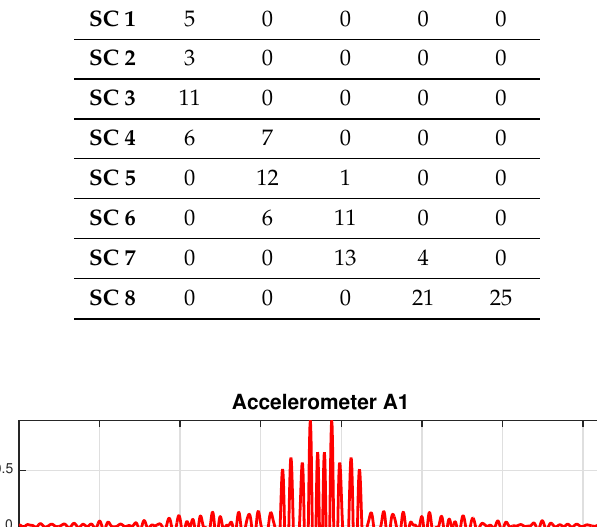
Table 2. Quantitative performance assessment for the K-means algorithm: confusion matrix. SC 1–8 are the obtained classes, while TC 1–5 are the ground truth-based classes. TC 1